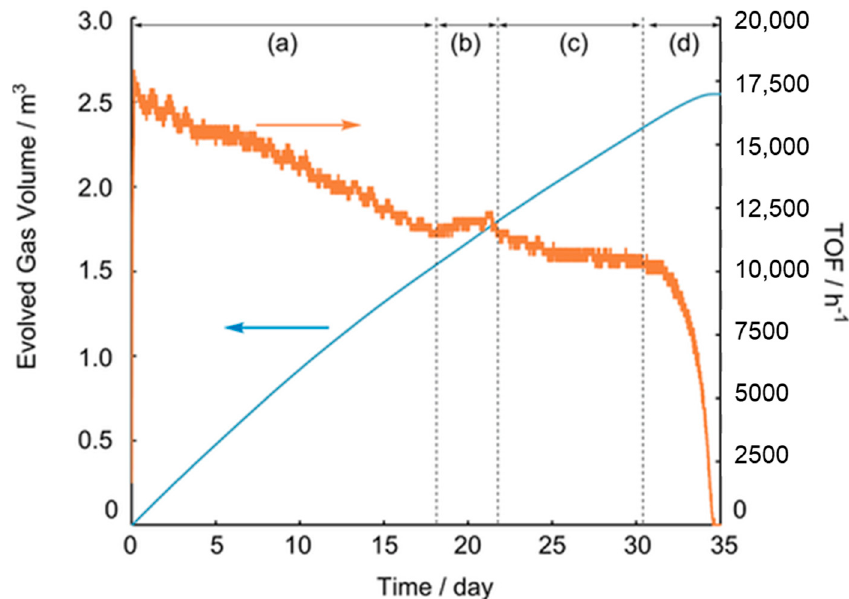
Figure 6. Time courses of volume of released gases (blue line) and rate of gas release (orange line) in FADH, with the continuous addition of FA by a pump. Conditions: [FA] 0 = 4.0 M, 500 mL, [ Ir-8 ] 0 = 10 μ M, [FA] add = 80 wt% (= 20 M), at 70 °C. Rate of FA addition: ( a ) = 0.07 mL/min, 420 h, 35.3 mol,